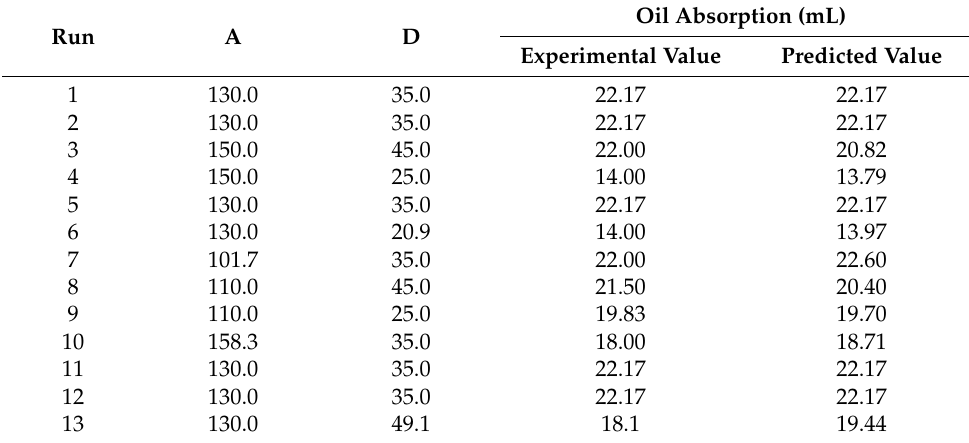
Table 5. Optimisation of parameters for diesel degradation using central composite design (CCD) (SD, n = 3).